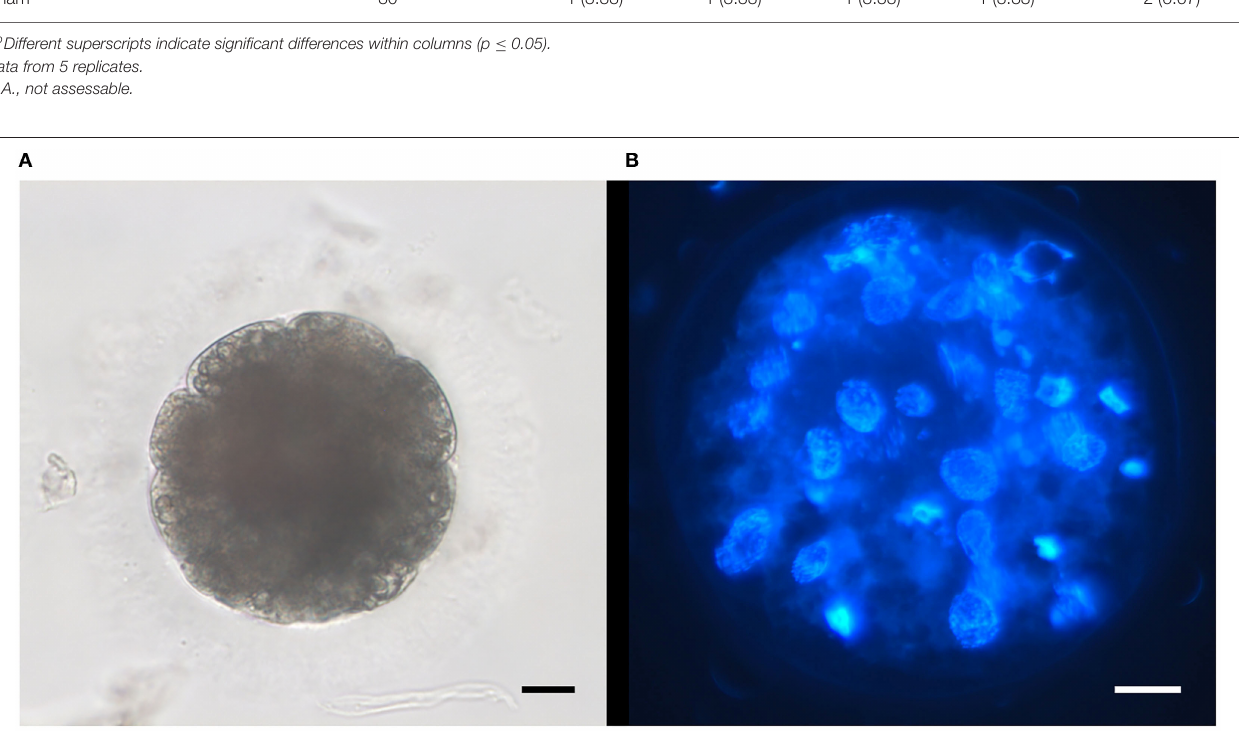
TABLE 3 | Embryonic development of in vitro matured feline oocytes after intracytoplasmic sperm injection (ICSI) with conspecific spermatozoa (ultra-rapid frozen or control slow-frozen) or after sham-ICSI. ICSI Number of injected oocytes Embryonic development of injected oocytes Ultra-rapid frozen spermatozoa 32 Slow-frozen spermatozoa Sham